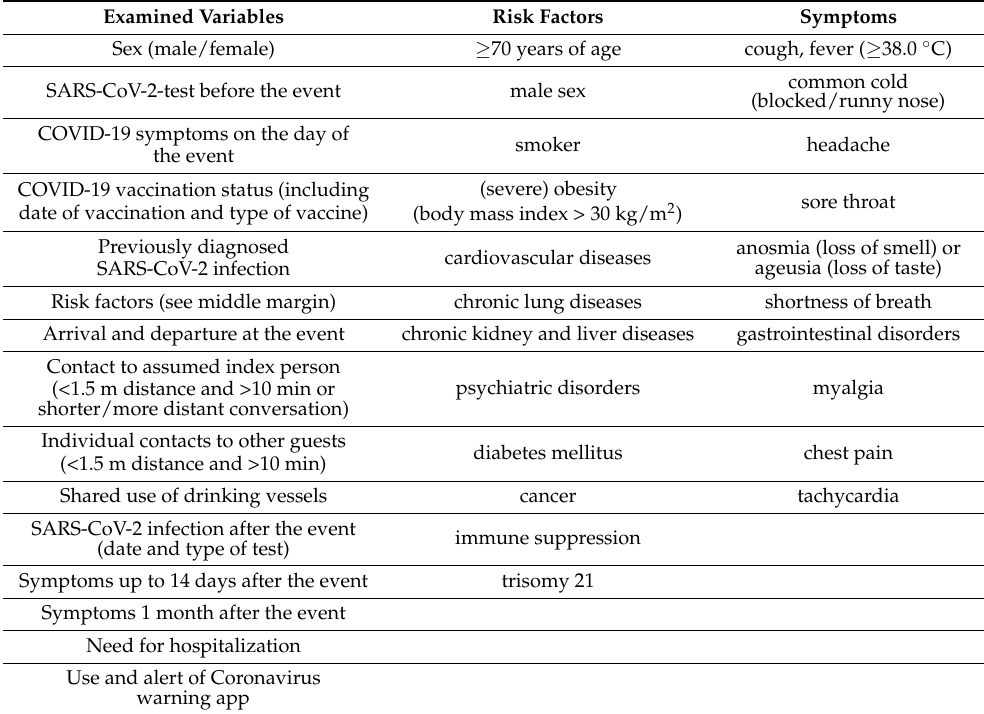
Table 1. Study variables and